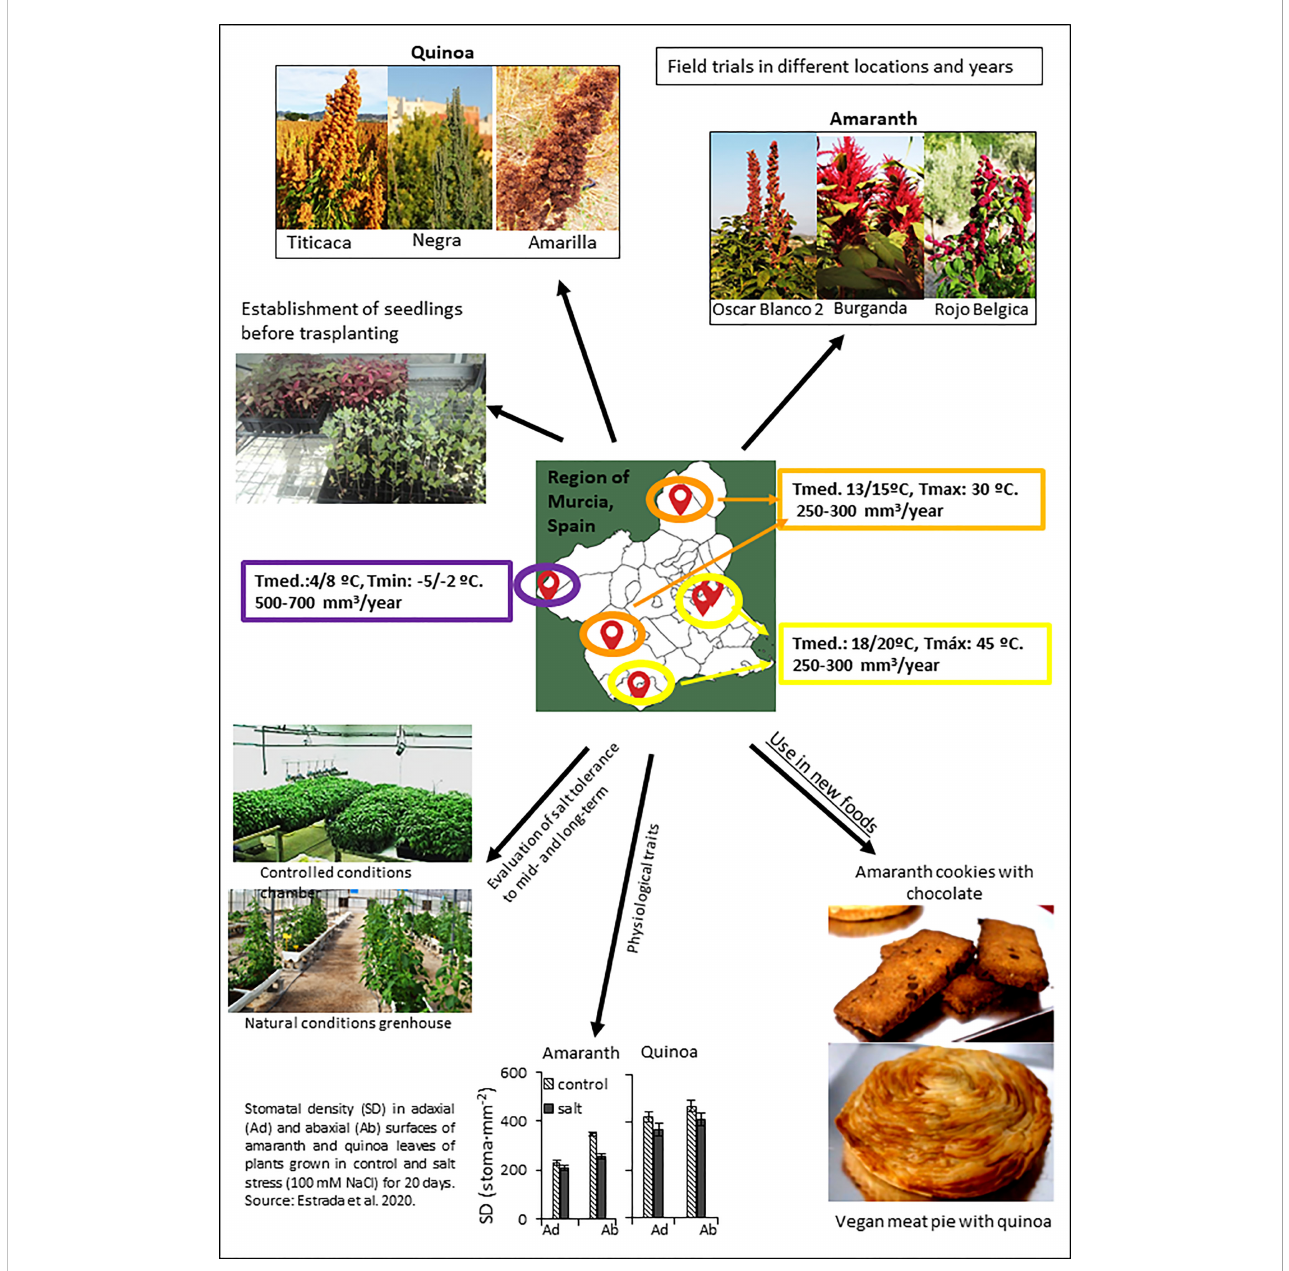
FIGURE 4 A schematic representation of activities carried out within the project “ Agro-Ecological Innovation Observatory against Climate Change ” (AEI-CC), focused in selection of quinoa and amaranth genotypes to be grown in the Spanish Southeast (Region of Murcia) with potential to climate change adaptation as well as exhibiting good organoleptic and nutritional qualities. Varieties with very different characteristics are being evaluated in fi eld trials in different locations (see map) to optimize the culture conditions and to achieve maximum seed yield and seed quality. In addition, salt tolerance is also being evaluated to select the best varieties under stress, by simplifying the selection of new varieties by means of analyzing physiological traits. Finally, the elaboration of new products based on amaranth and quinoa in food industries is another objective of the